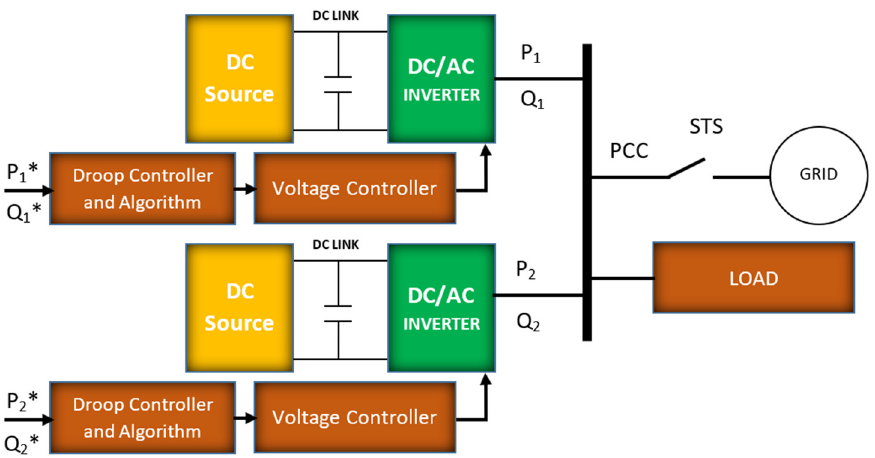
Figure 2. Two inverters in the microgrid.